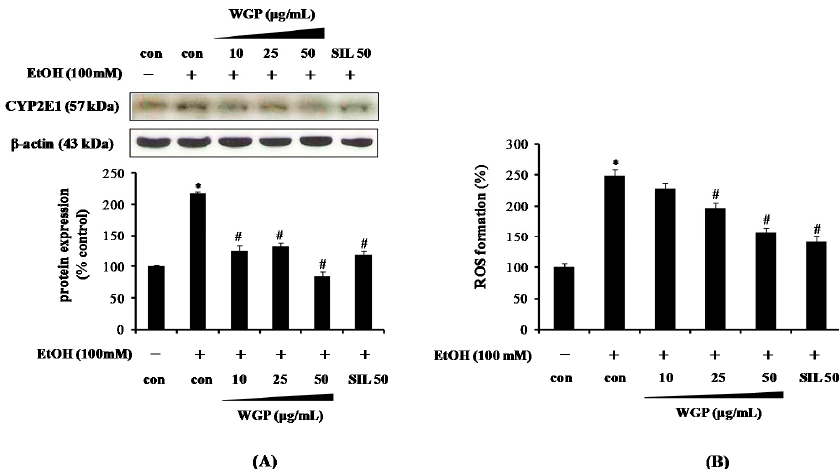
Figure 2. Effect of WGP on cytochrome P450 2E1 (CYP2E1) protein expression and reactive oxygen species (ROS) production in ethanol-treated HepG2 cells. ( A ) CYP2E1 protein expression; and ( B ) ROS production. Cells were pretreated with vehicle or WGP for 1 h before incubating with ethanol (100 mM) for 24 h. Values are the mean of three independent experiments ± SD ( n = 3). * p < 0.05 indicates differences from the unstimulated-control group; # p < 0.05 indicates differences from the ethanol-treated group.